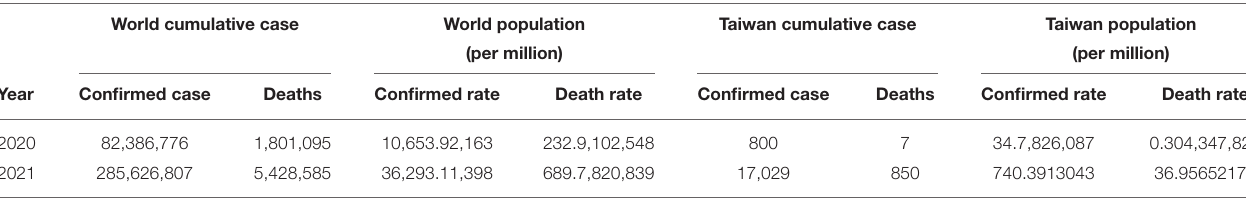
TABLE 1 | The cases of COVID-19 in Taiwan and worldwide in 2020 and